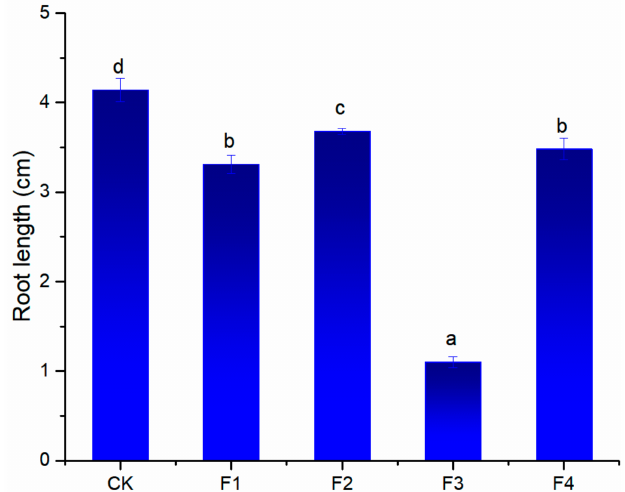
Figure 2. Effect of the fractions obtained from the ethanol extract of S. mukorossi pulp against the root growth of T. pratense at a concentration of 160 mg/L. CK: untreated plants (control). F1, F2, F3 and F4 represent 30, 50, 70 and 95% ethanol fraction, respectively. Values represent the means ± standard deviation (SD) from three replicates with ten seedlings. Different letters (a, b, c and d) indicate significant differences among treatments by ANOVA ( p = 0.05).